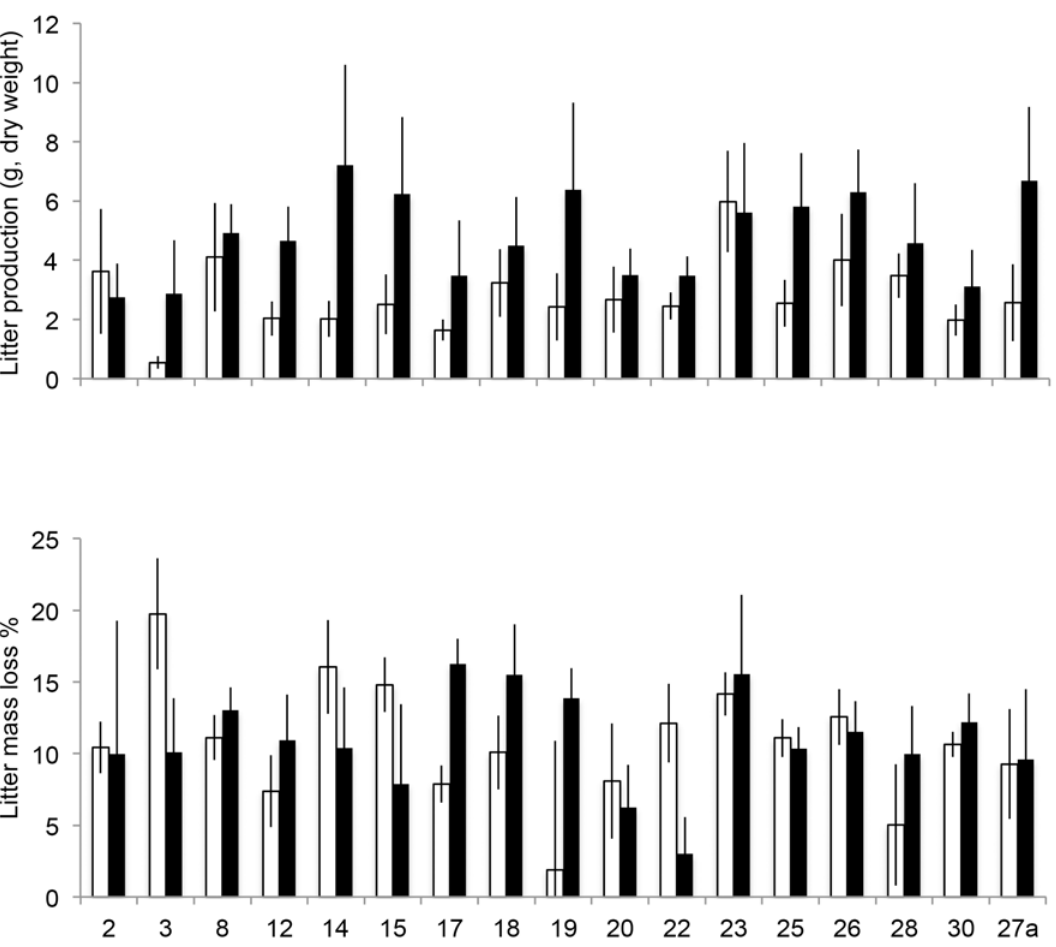
Figure 2. Leaf litter production and litter mass loss of the insecticide treated (black bars) and control (white bars) saplings of 17 B. pendula genotypes (mean ± SE, n = 4 – 6 for each